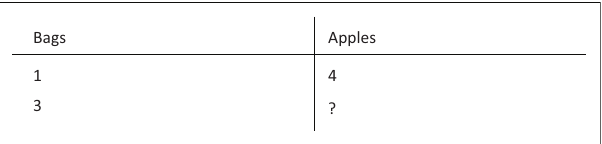
FIGURE 1: T- table for simple proportion problem.